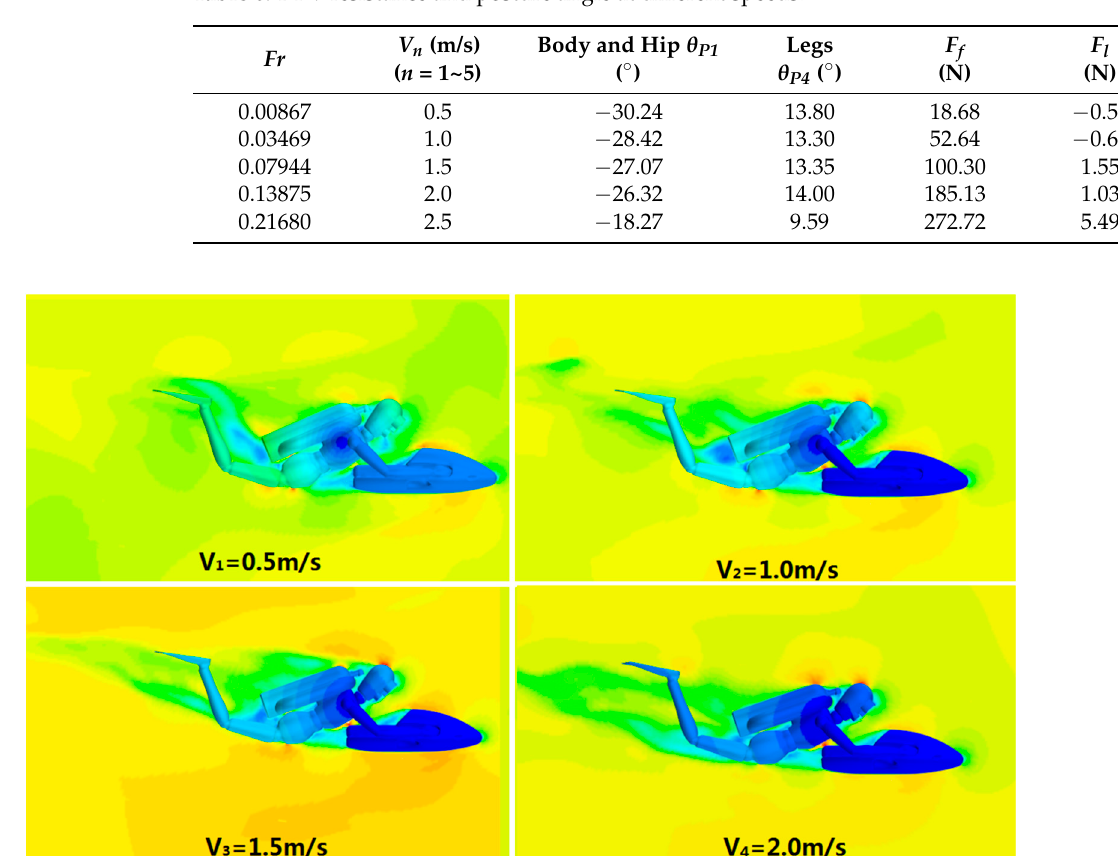
Figure 21. Velocity scalar nephogram at 2s moment at other four cruising speeds.